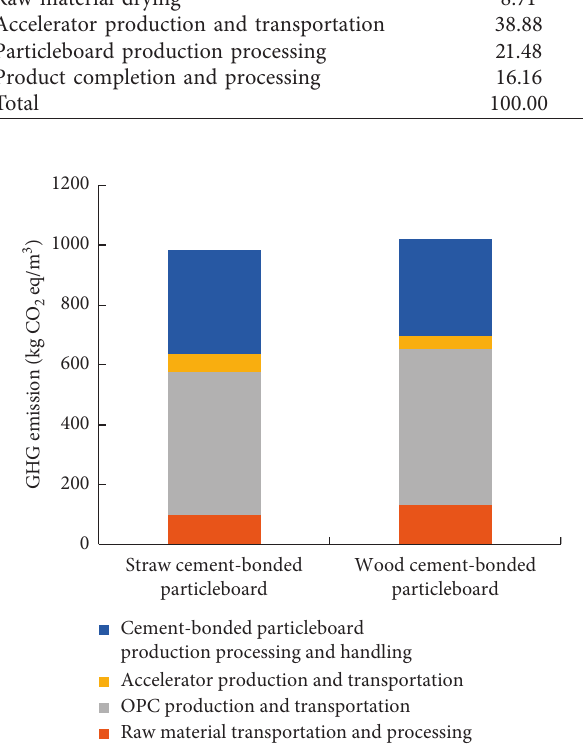
Figure 5: Contribution of cement-bonded particleboard produc- tion process to GWP impact.